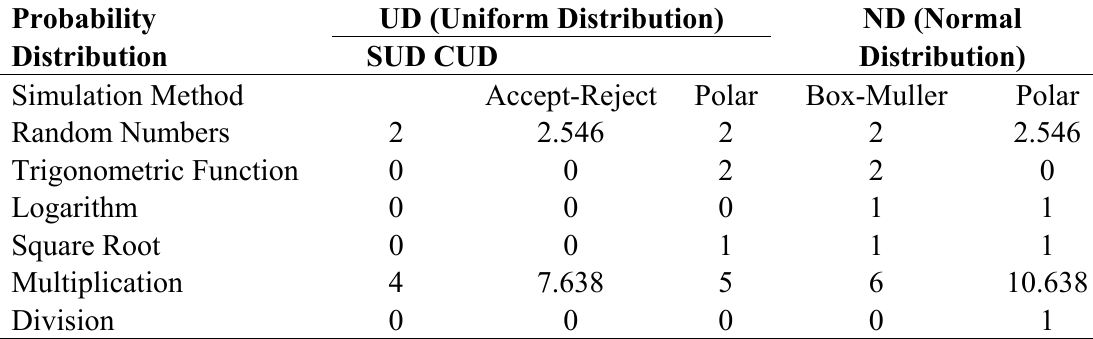
Table 1. The efficiency of different